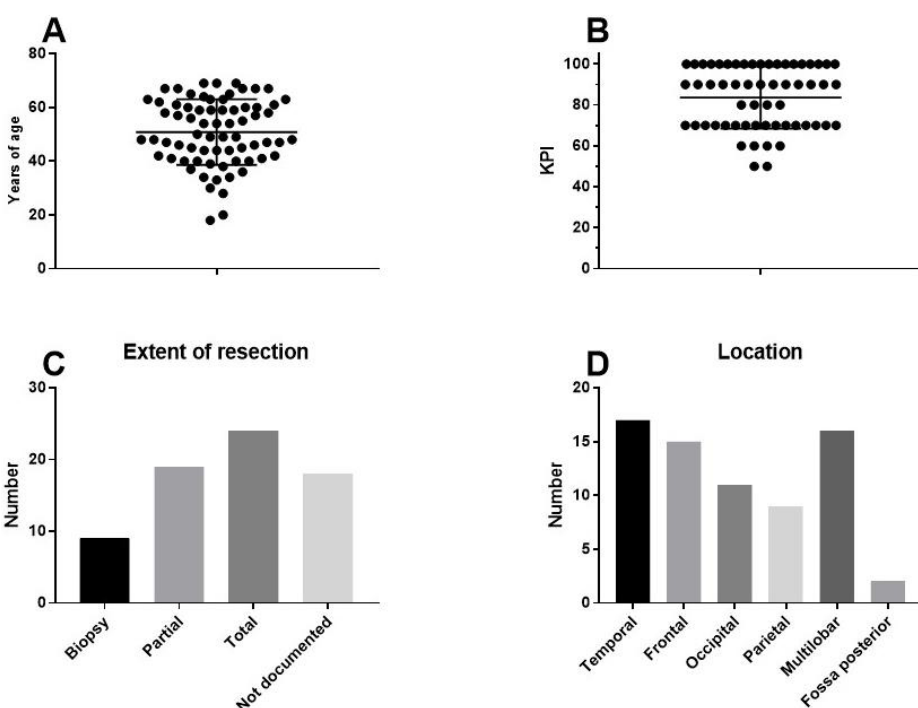
Figure 1. Clinical characteristics of the patients. Seventy adults with primary GBM receiving first- line standard of care in combination with individualized multimodal immunotherapy were in-